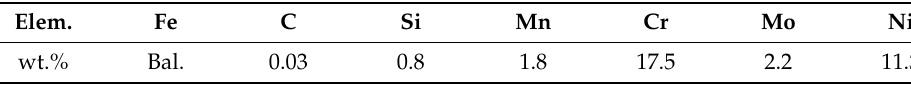
Table 1. Chemical analysis of TLS stainless steel 316L powder.